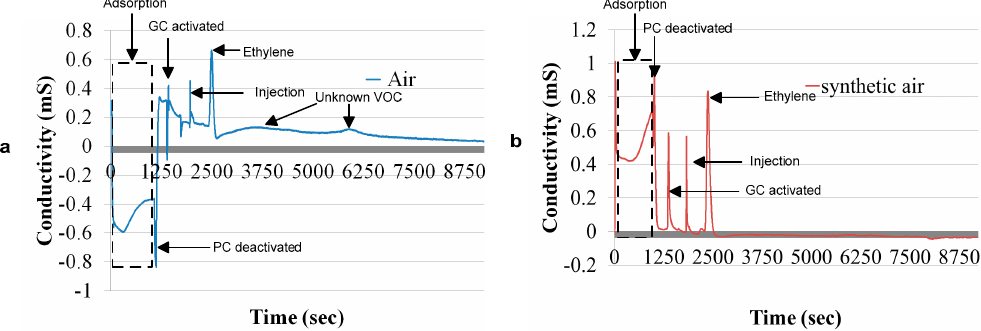
Figure 9. ( a ) 400 ppb with a metal oxide gas sensor and an ambient air carrier gas; ( b ) 400 ppb with a metal oxide gas sensor with a synthetic air carrier gas.